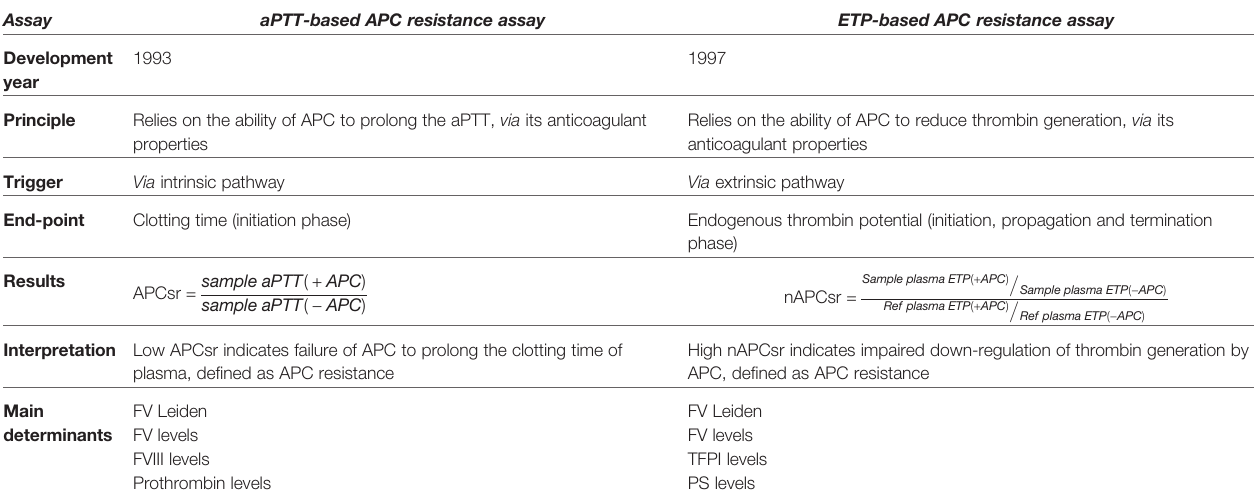
TABLE 2 | Assessment of acquired activated protein C resistance.